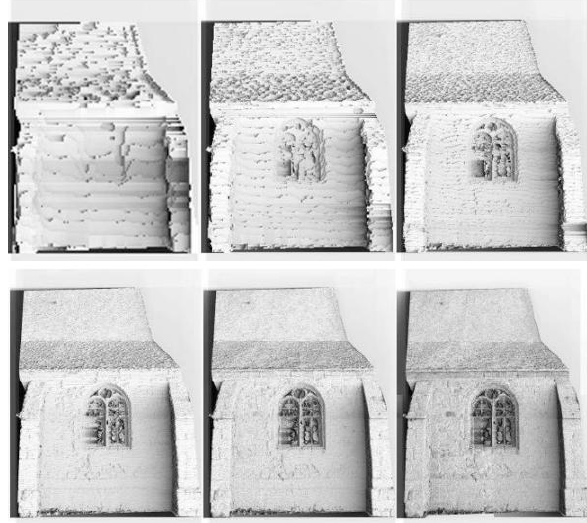
Figure 1: Pyramidal approach: example of results during the multi-scale